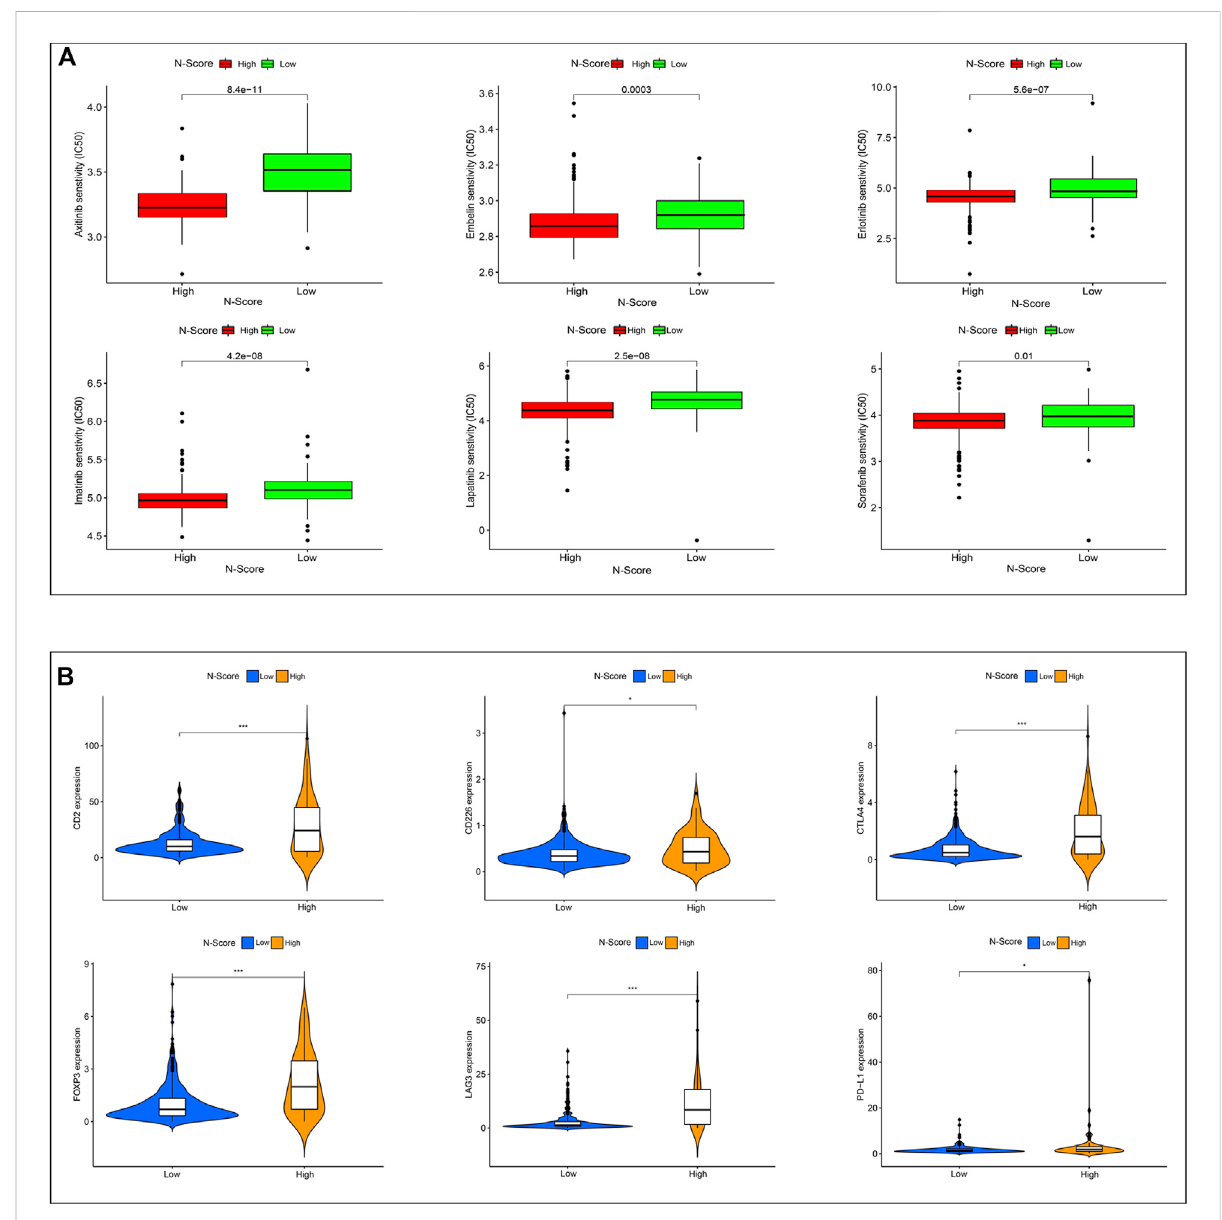
FIGURE 7 Effect of N-Score in the therapy of ccRCC patients. (A) The molecular response of two N-Score groups for six common molecular drugs (Axitinib,Embelin,Erlotinib,Imatinib,Lapatinib,andSorafenib). (B) Theexpressionofsiximmunecheckpointmolecules(CD2,CD226,CTLA4,FOXP3, LAG3, and PD-L1) in two N-Score groups (*: p < 0.05, **: p < 0.01, and ***: p <